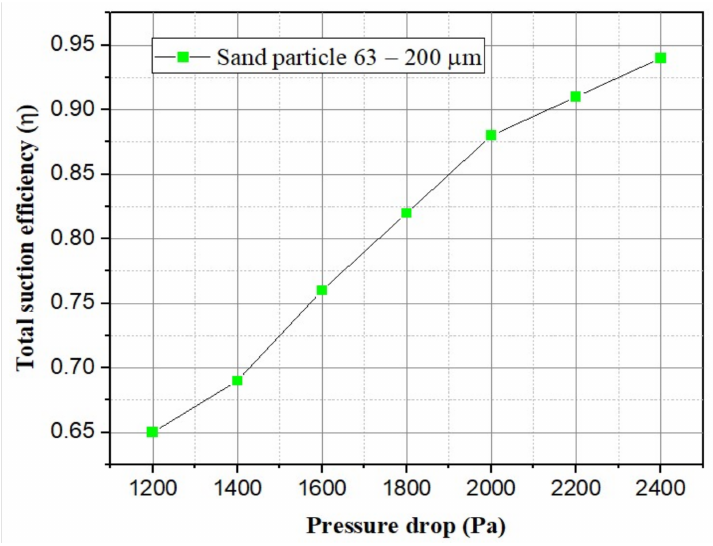
Figure 14. Experimental result effects of pressure drops on suction